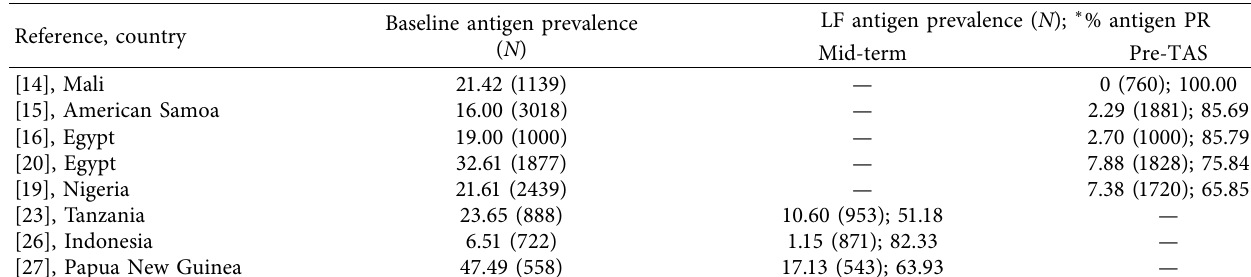
Table 4: Percentage antigenic prevalence reduction at mid-term and pre-TAS compared to baseline prevalence in LF mass drug